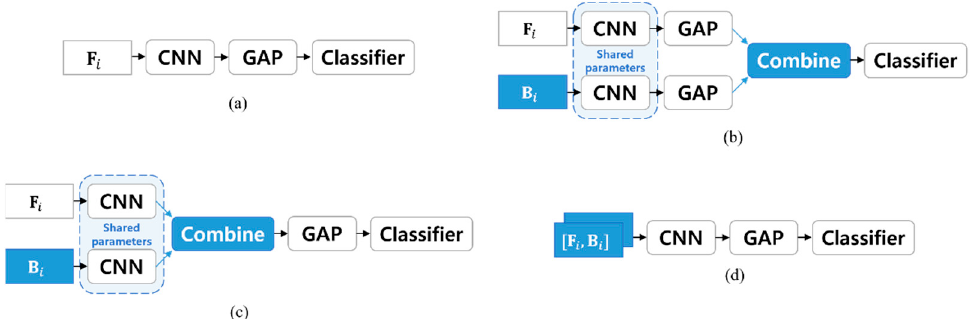
Figure 3. The framework of ( a ) conventional and ( b – d ) proposed systems, where GAP stands for global average pooling, Combine ( b , c ) stands for one of the appropriate combination methods (described in Sections 3.2.1 and 3.2.2, respectively), and F i and B i are the i -th forward and backward segments, respectively. The proposed systems consist of ( b ) embedding-level combination, ( c ) feature-map level combination, and ( d ) two-channel input. The modules for the proposed method are marked in blue.